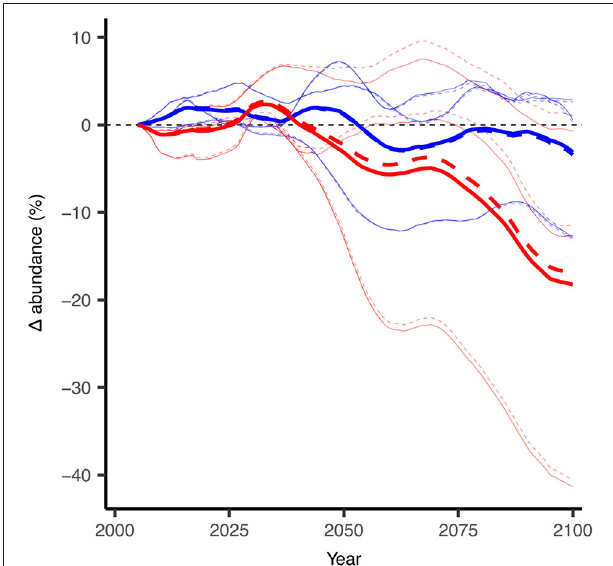
FIGURE 8 | Projected changes in abundance for Arctic cod ( B. saida ) with and without the modeled effects of ocean acidification as simulated with the DBEM. Thin lines indicate the individual DBEM results with forcing input from each of the three earth system models (GFDL, IPSL, MPI). Thick lines represent the averaged results from the respective three runs. Dashed lines indicate DBEM results which include impacts of ocean acidifcation on Arctic cod (For every 100 % increase in acidity, i.e., hydrogen concentration, ocean acidification was modeled to negatively affect both growth and survival by 20 % ), solid lines include no acidification effect on the species. Changes in abundance are 10-year running means and relative to the 2001–2010 average. Red indicates the DBEM results forced with ESMs using the high CO 2 emission scenario (RCP8.5) and blue indicates results for the low emission scenario (RCP2.6). Modified from AMAP (2018) with permission from